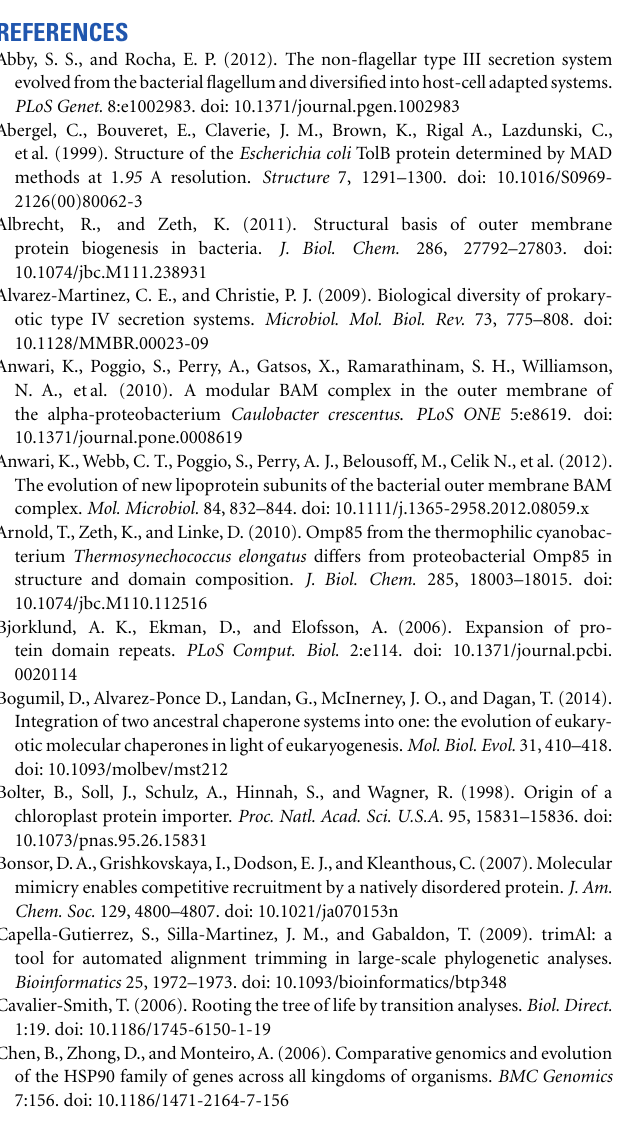
Table S1 | List of all UniProt accession numbers of Omp85 proteins in their respective clusters. Table S2 | List of the domain profiles identified for the main clusters based on the annotation of Pfam domains in Interpro. Table S3 | Summary of the prediction results using Phyre2 of sequences with novel domain profiles. Table S4 | List of all bacterial species with a completed proteome according to the UniProt database at the time of analysis, which lack a protein similar to BamA. Organisms that represent exceptions (highly reduced obligate intracellular bacteria, organisms with indications for Gram-positive or Gram-negative cell envelope) are highlighted in green, organisms where a BamA would be expected due to its presence in all other strains of the respective species are highlighted in red. All taxa underlined in gray are described to display a Gram-positive cell